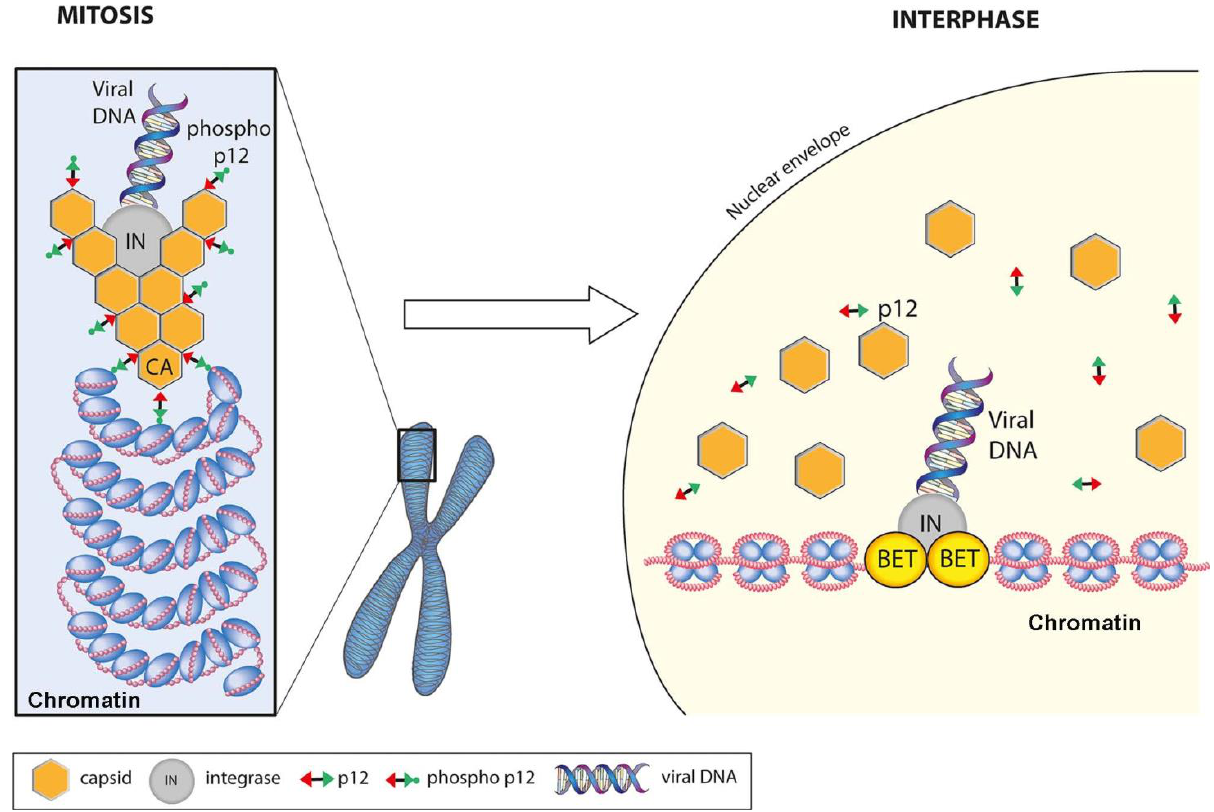
FIGURE 2: A model for gammaretroviral p12 function in the early stages of infection. In the mature virion, the NTD of p12 directly binds to and stabilises the hexameric CA lattice that surrounds the viral core. The gammaretroviral PIC, minimally carrying p12, CA, IN and the viral cDNA must wait until mitosis, when the nuclear envelope disassembles, to gain access to host chromatin. The PIC is then tethered to nucleosomes by CA-bound, phosphorylated p12. Exit from mitosis triggers the de-phosphorylation of p12 and the dissociation of p12 and CA from chromatin. This then reveals the intasome, consisting of viral cDNA and IN. IN can then bind to chromatin-associated BET proteins and direct the viral cDNA to gene promoter regions where it then catalyses integration of the viral cDNA into host chromatin to form a